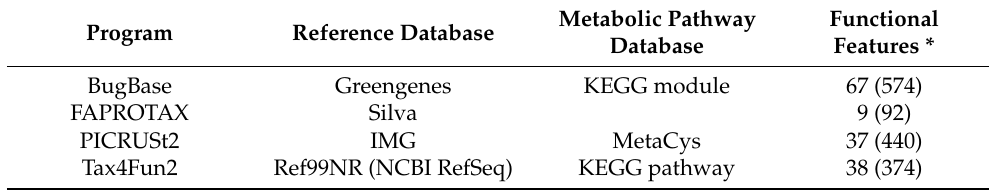
Table 2. Overview of four computational programs and the functional